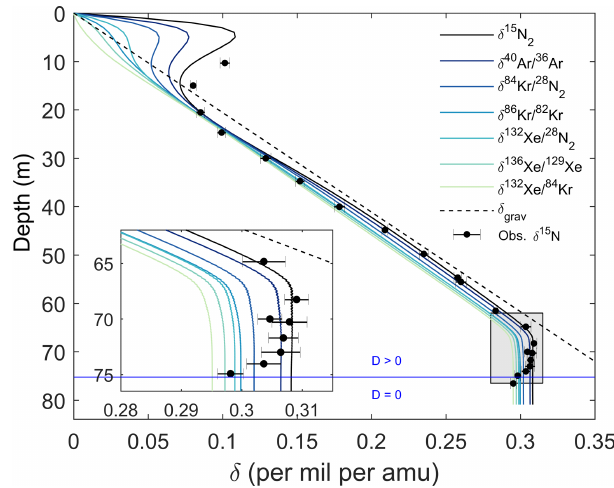
(cid:48) ) profiles for Figure 12. Differential kinetic isotope fractionation ( (cid:15) different isotope pairs at WAIS Divide. Colored solid and dashed lines show results from the 2-D model with and without barometric pumping, respectively. (cid:15) (cid:48) is defined as the (typically negative) dif- ference between any mass-normalized isotope ratio and δ 15 N (see text). Subscripts of one or two element names identify ratios as iso- tope or elemental ratios, respectively. The dashed black line high- lights where molecular diffusivity in the model reaches